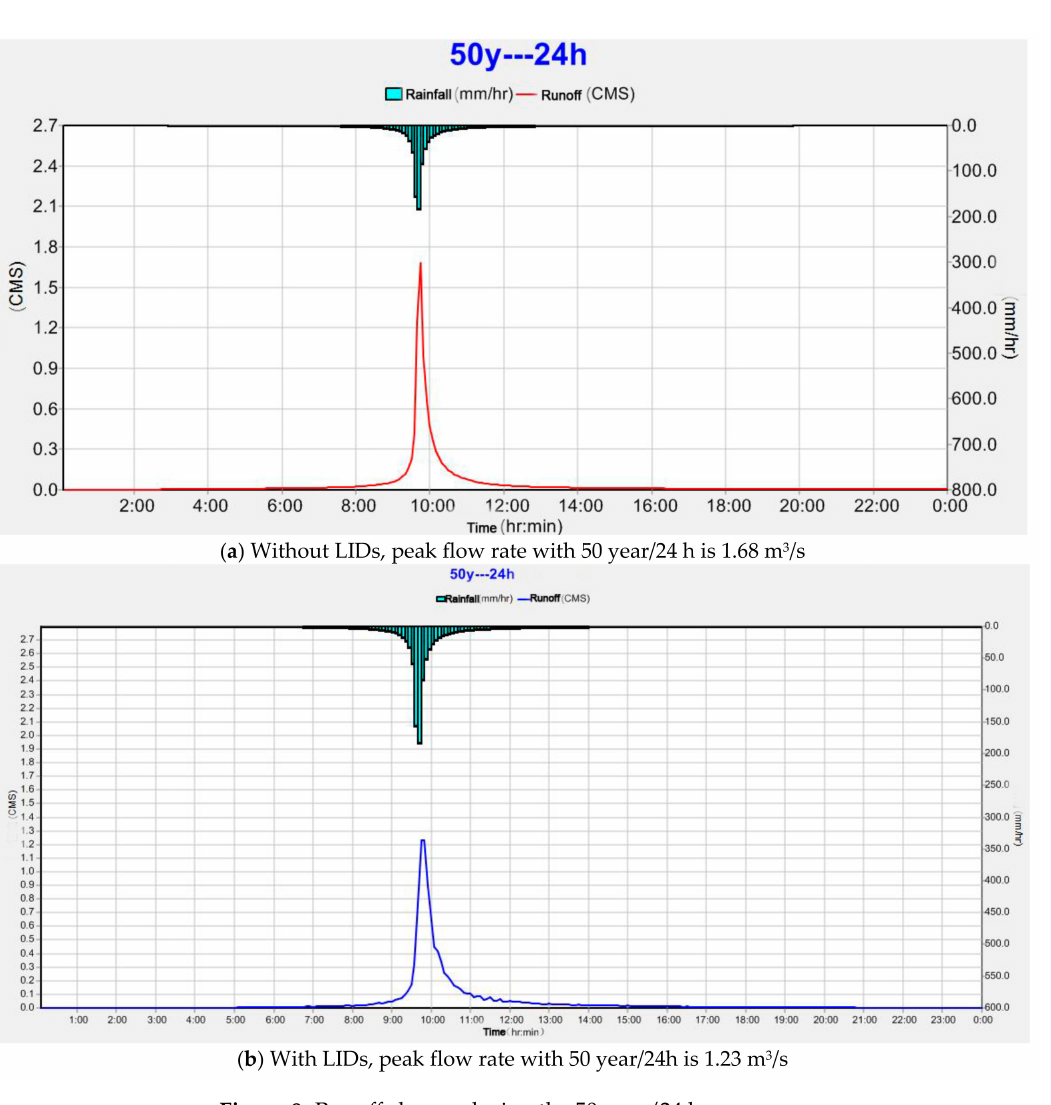
Figure 9. Runoff change during the 50 year/24 h